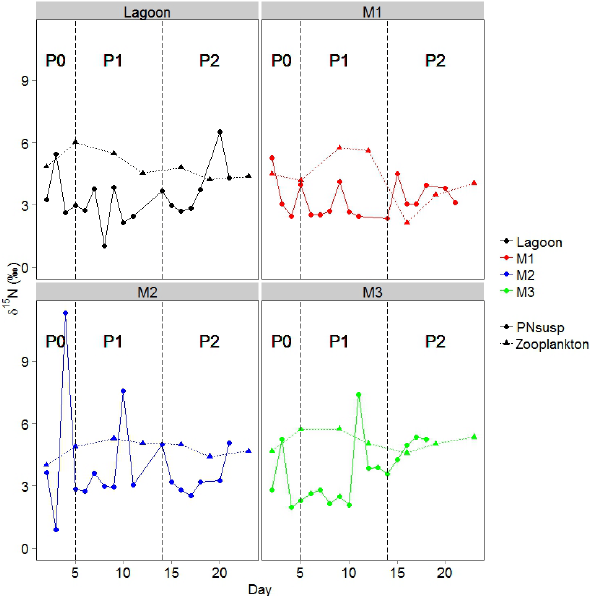
Figure 5. Nitrogen isotope ( δ 15 N) values of zooplankton and sus- pended particulate nitrogen (PN susp ) over the course of the 23-day VAHINE experiment (13 January–4 February 2013) for the three VAHINE mesocosms (M1–3) and the lagoon waters. P0, P1, and P2 refer to the pre-phosphorous fertilization, DDA-dominated, and UCYN-C-dominated periods of the experiment, respectively. Zoo- plankton values are indicated by a solid line and PN susp by a dashed line.